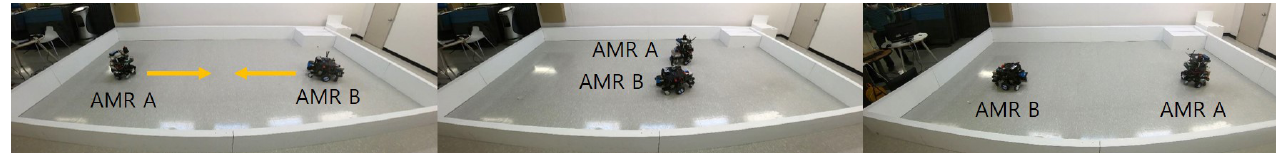
Figure 7. AMR A and B under the fleet layer.